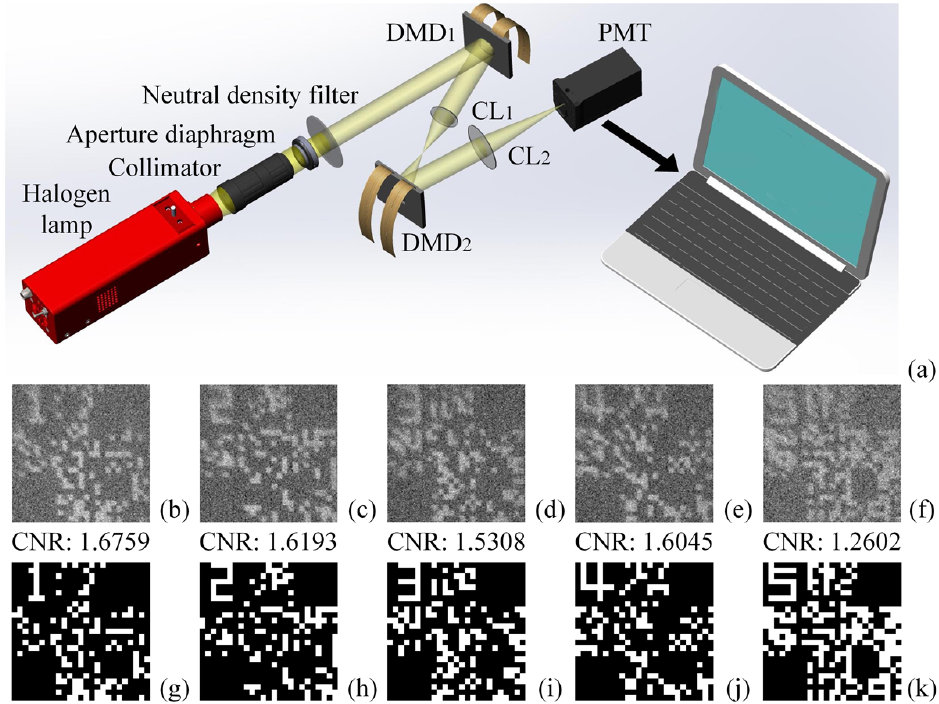
Figure 4. Experimental setup ( a ) and results ( b–k ). ( b – f ) Five recovered ghost images of 200 × 200 pixels ( ν = 8) with N = 40,000; ( g – k ) the binarized results of ( b – f ). DMD: digital micromirror device; CL: convergent lens; PMT: photomultiplier